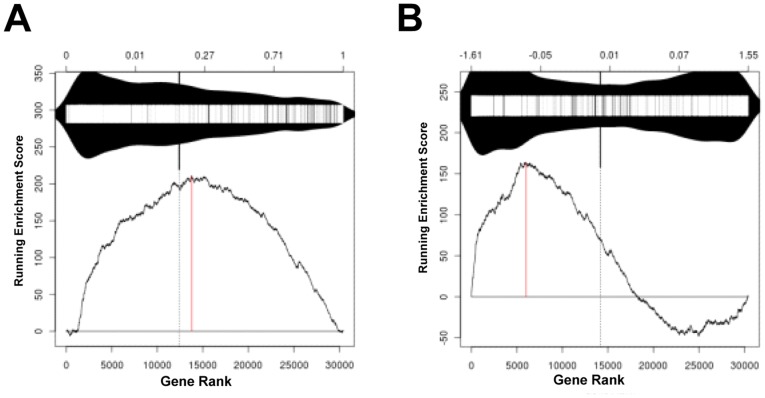
Comparative analysis of ChIP-seq and microarray data.
A-B. KS plots showing correlation between CTNNB1 binding and expression regulation. The 2794 CTNNB1-bound genes were compared for their correlation with expression changes upon siRNA knockdown of CTNNB1. Genes in the microarray were ranked by p value (A, p  =  4.4e-16) or fold increase (B, p  =  0) in each GSEA.